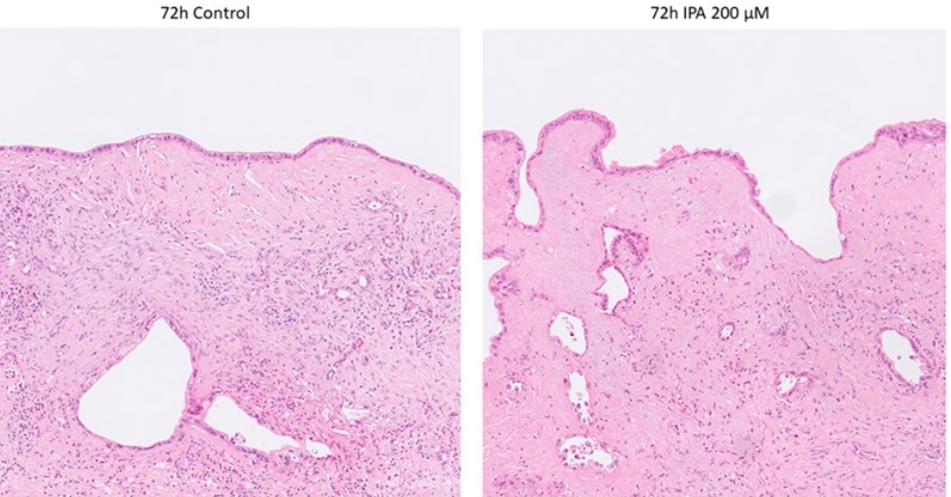
Figure 2. Representative photomicrographs of control and IPA-treated ex vivo cultured tissue slices.